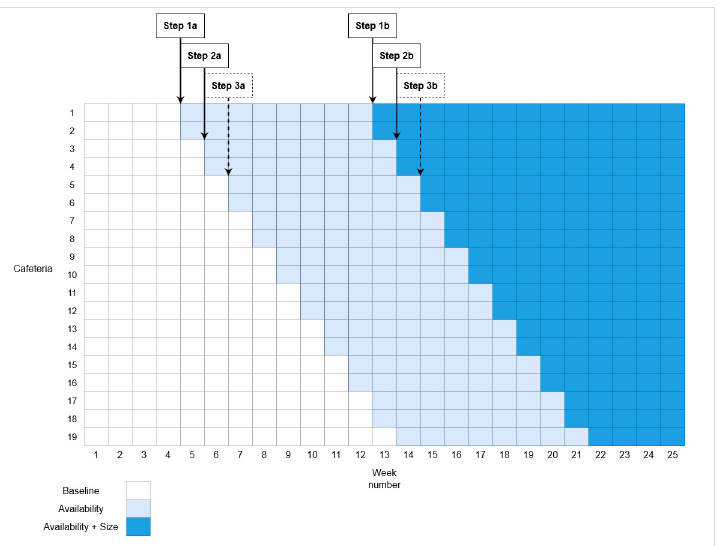
Fig 2. Stepped-wedge study